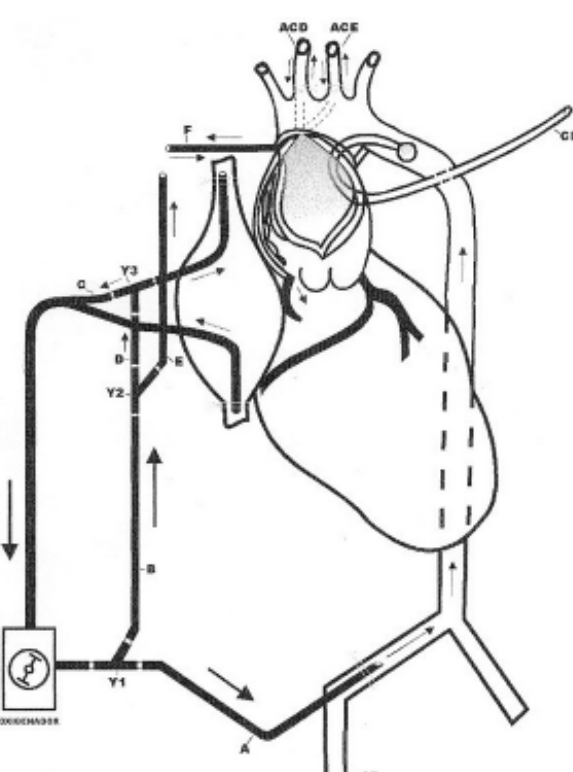
Fig. 1 – Desenho esquemático do sistema de circulação extracorpórea empregado. Linha A (perfusão femoral); linha B (D-perfusão retrógrada, E-perfusão anterógrada); linha C (drenagem venosa habitual das veias cavas); linha F (perfusão das carótidas). CB - cateter-balão; Y1,Y2,Y3 - conectores em